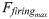
Influence of input- and output-scaling parameters on reward-growth functions.The upper panels show logistic reward-growth functions, whereas the lower panels show power functions. Thus, the upper panels are analogous to Fig 1, but in double-logarithmic, rather than semi-logarithmic, coordinates, and using pulse-frequency values typical of oICSS rather than eICSS experiments. Solid lines map the pulse frequency into the reward intensity using the assumed frequency-following function (see: Parameters of the frequency-following function for oICSS). FFmax is the maximum firing frequency (Ffiringmax) attainable given the form and parameters of the assumed frequency-following function. The dashed lines map the firing frequency into the reward intensity. (These lines are drawn assuming perfect frequency-following fidelity (FFmax = ∞), and thus pulse frequency and firing frequency are equivalent.) In the case of the logistic reward-growth functions in the upper panels, changing the values of the input- and output-scaling parameters produces independent effects, shifting the reward-growth function in orthogonal directions. In contrast, changing the values of the input- and output-scaling parameters produces identical effects on the power-growth functions plotted in the lower panels.